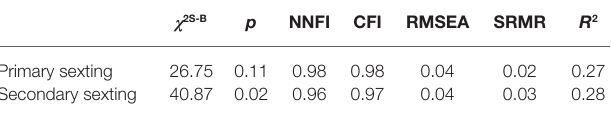
TABLE 3 | Fit indexes of the models to the active